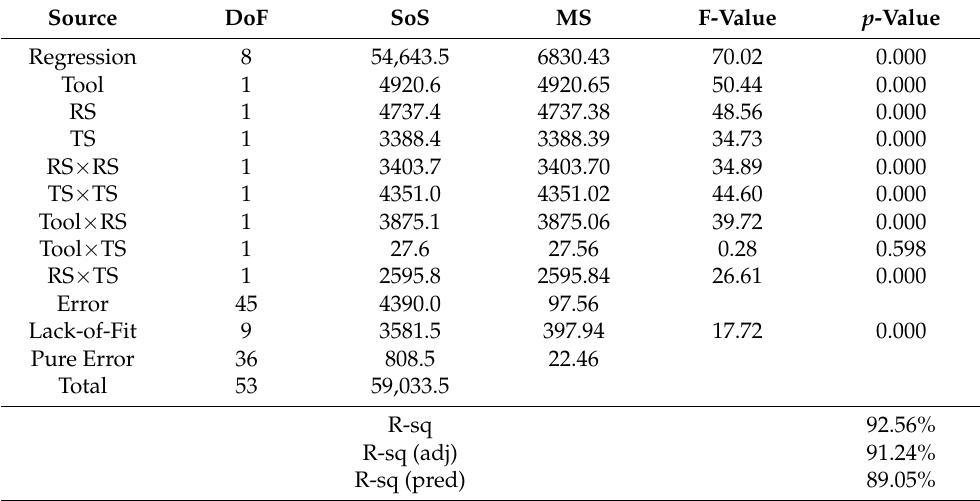
Table 5. Analysis of Variance—ANOVA: WT versus Tool; RS;